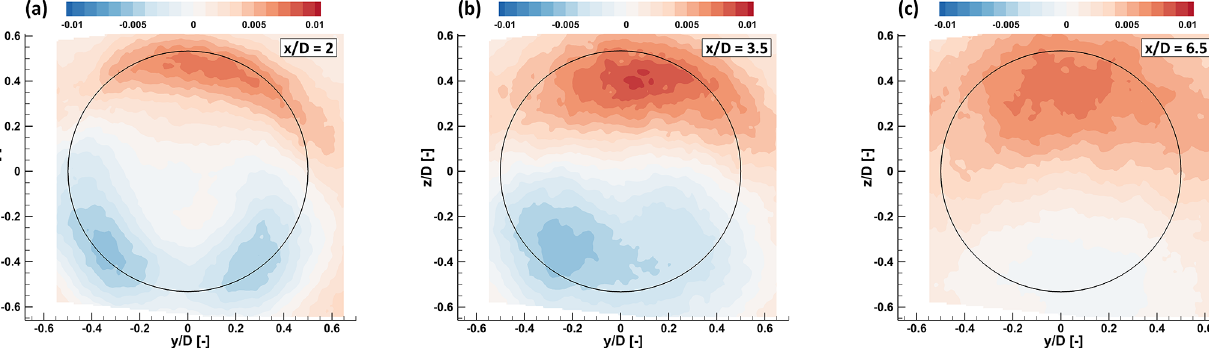
for UTD-HT inflow at several downstream distances. The black circle denotes hub